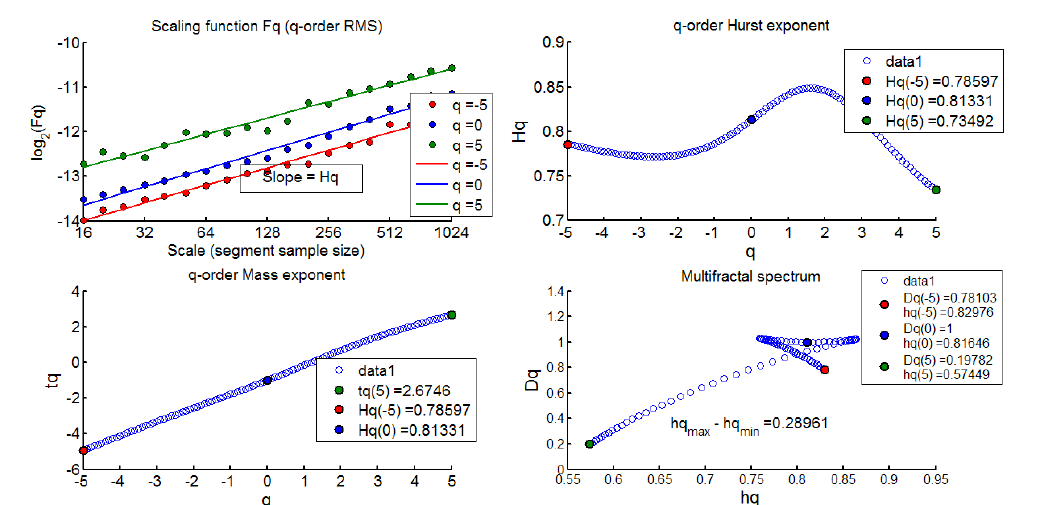
(5) of Nifty Energy index on June 15, 2020, i.e., ( t = Figure 4. The H q